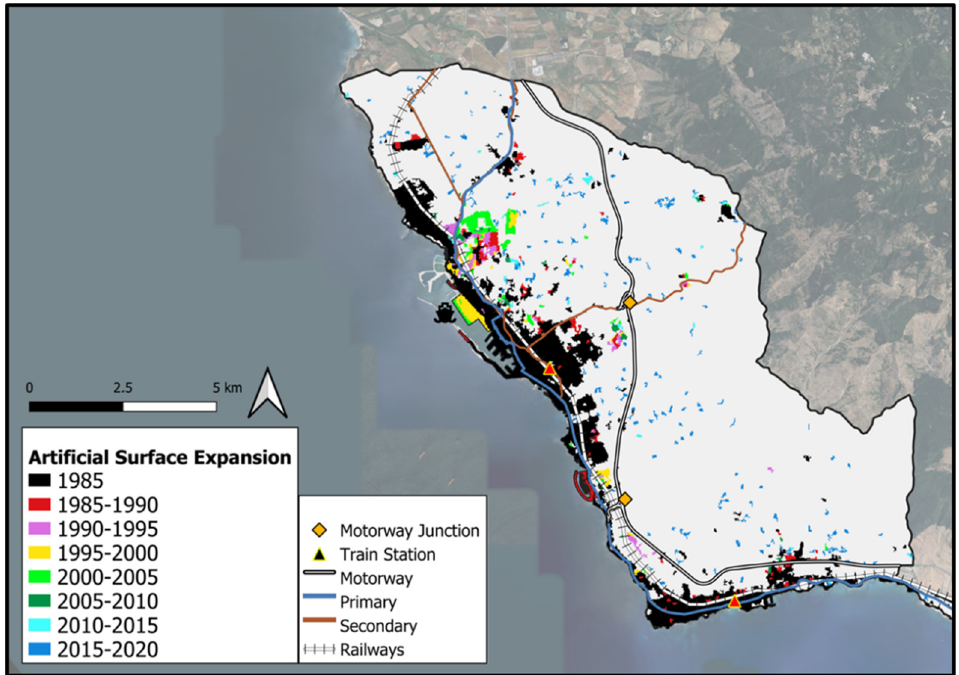
Figure 12. Artificial surface evolution in the municipalities of Civitavecchia and Santa Marinella through the years. Image sieved at a threshold of 10 pixels, 8-bit connectivity.